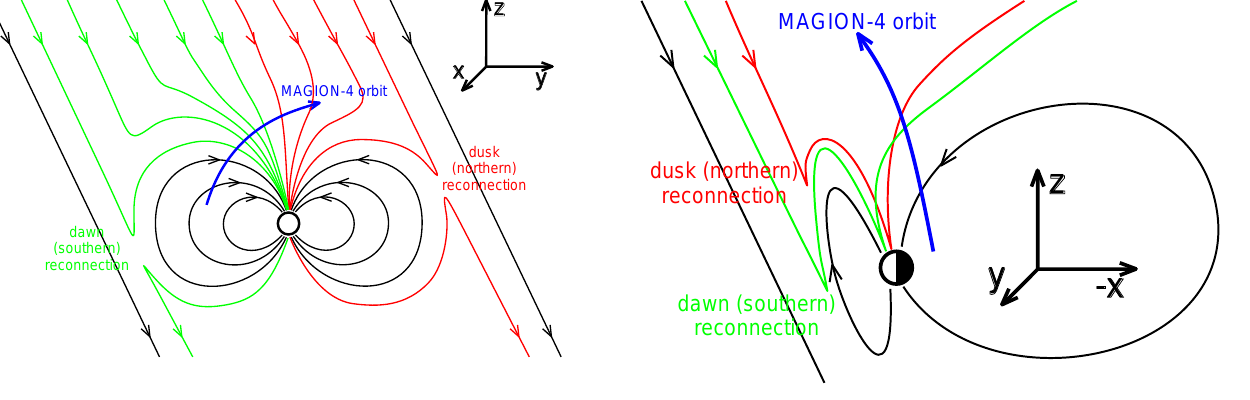
Fig. 9. Schematic drawing of latitudinally separated reconnected field